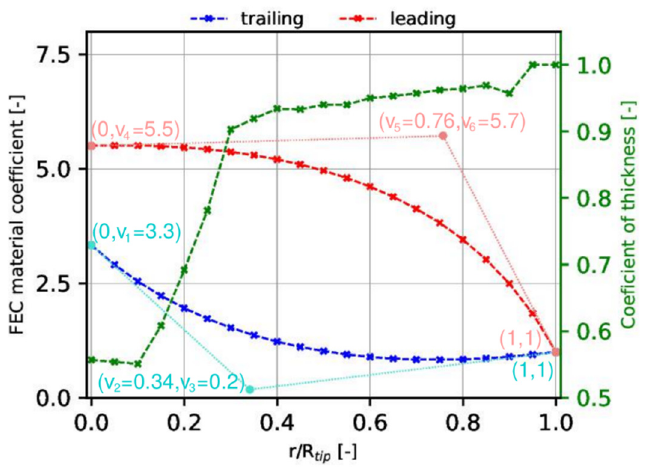
Figure 5. Material FEC (CASE A): coefficients of change in thickness of the materials ‘TRIAX’ and ‘UNIAX’, for the regions H/P “trailing” and L/P “leading” and global coefficient of the cross-section thickness (with green color). Cyan and orange symbols depict control points, connected with straight lines.